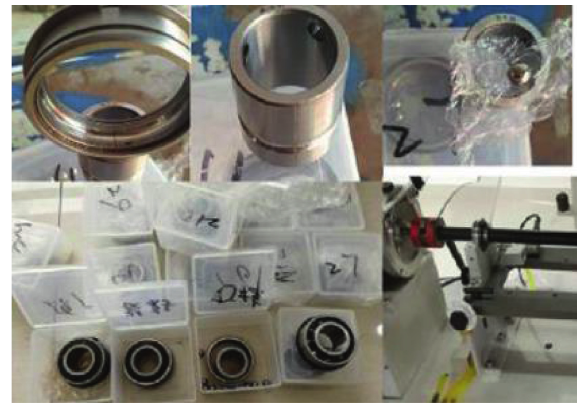
Figure 21: SER205 bearings.